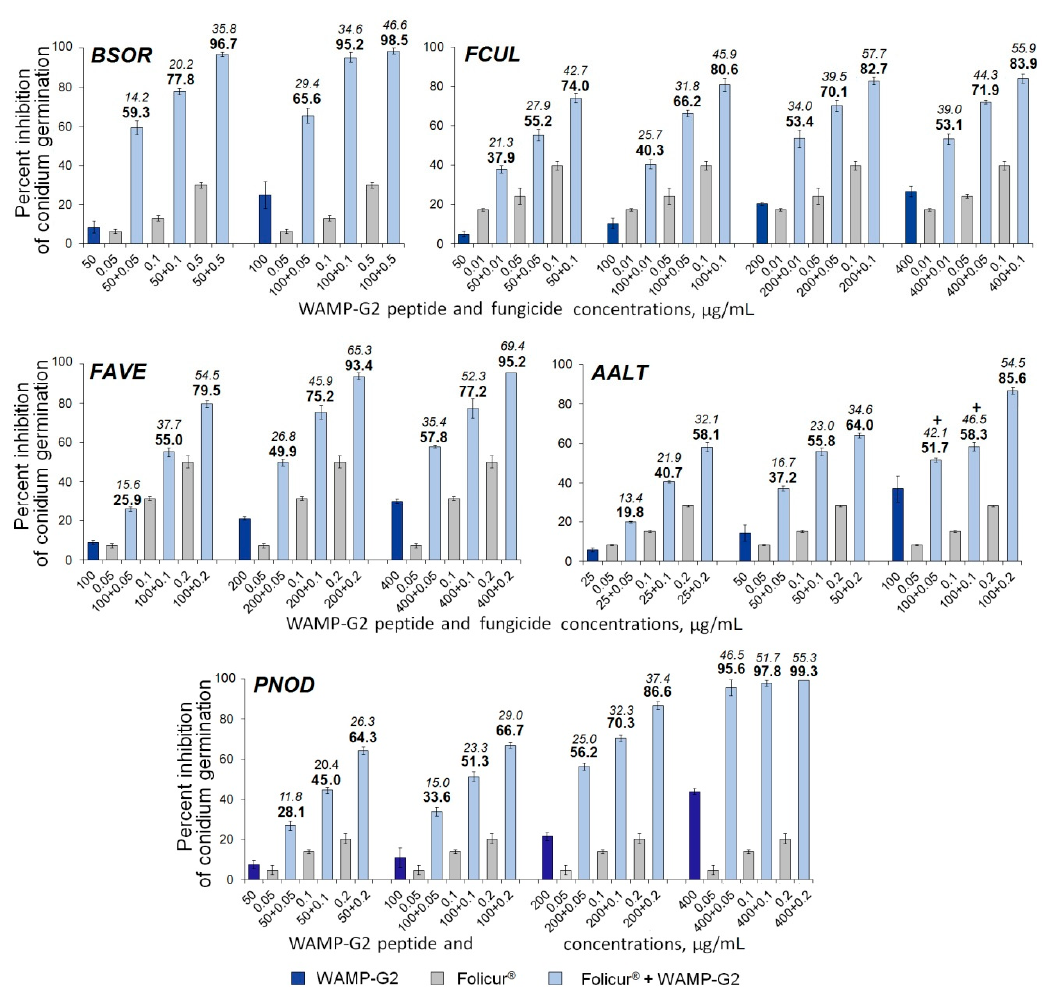
Figure 9. Histograms showing the enhancement of the fungicidal e ffi cacy in suppression of spore germination in five fungi pathogenic to cereal crops due to synergistic or additive interactions between WAMP-N and the fungicide combined at di ff erent concentrations. Concentration combinations providing an additive e ff ect are marked with pluses. BSOR , FCUL , FAVE , AALT , and PNOD are B. sorokiniana , F. culmorum , F. avenaceum , A. alternata , and P . nodorum , respectively. See Figure 6 caption for additional